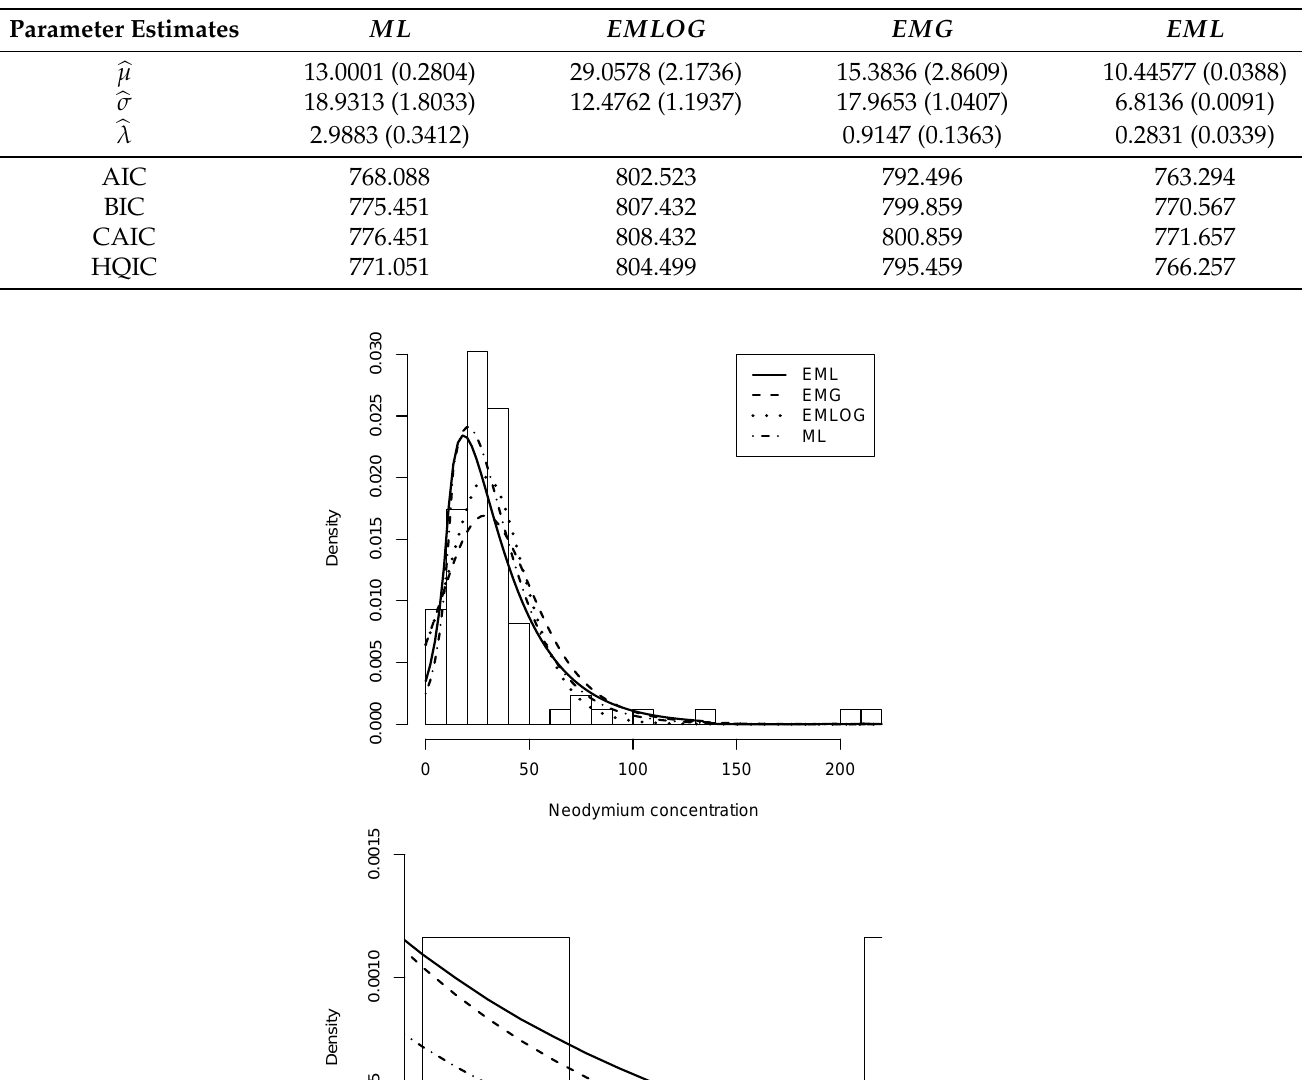
Table 7. Maximum likelihood estimators for models ML , EMLOG , EMG , and EML for the neodymium concentration data set in the soil, with their corresponding standard deviations in parentheses and comparison criteria AIC, BIC, CAIC, and HQIC.